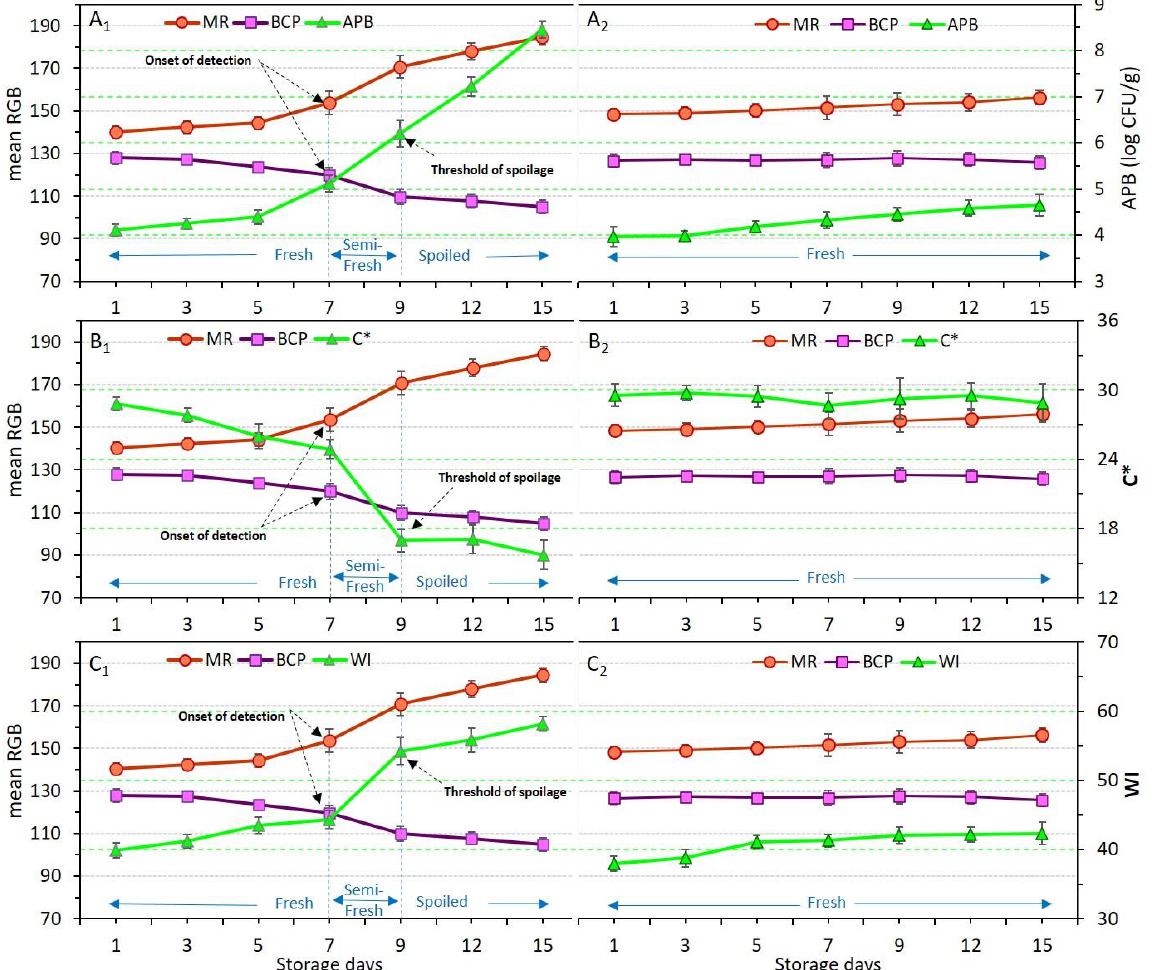
Figure 7. Variations of total aerobic psycrotrophic bacteria (APB) count ( A ), chroma index (C*) ( B ) and whiteness index (WI) ( C ) in relation to dual-sensors color responses (measured as mean RGB) in chicken meat samples without coating (control, ( A1 – C1 )) and coated with chitosan containing YEO (Ch_2% — YEO_0.3%, ( A2 – C2 )) during chilled storage days. Data are mean of at least triplicate measurements and error bars indicate SDs. MR: methyl red, BCP: Bromocresol purple. Onset of detection and threshold of spoilage in relation to APB, C*, and WI values has been shown by arrows.